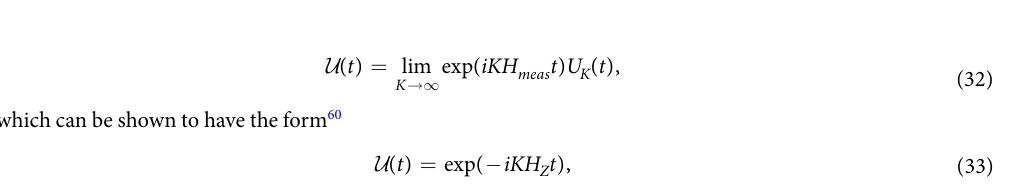
Figure 6. The fidelity of W state fusion scheme for the two atoms in two separate cavities with λ = 1, v = λ , λ Ω = . 0 01 , Δ = 0.8 λ . ( a ) Fidelity of the fusion varies with t when γ = 0, 0.05 λ , 0.1 λ , respectively. ( b ) Fidelity of the fusion varies with t when κ = 0, 0.05 λ , 0.1 λ , respectively. ( c ) Fidelity of the fusion varies with t when κ f = 0, 0.05 λ , 0.1 λ , respectively. ( d ) Fidelity of the fusion varies with decay ratio. Green dot dashed line is the fidelity varies with κ / λ when γ = 0, κ f = 0. Blue dot line is the fidelity varies with γ / λ when κ = 0, κ f = 0. Red dashed line is the fidelity varies with κ f / λ when κ = 0, γ =